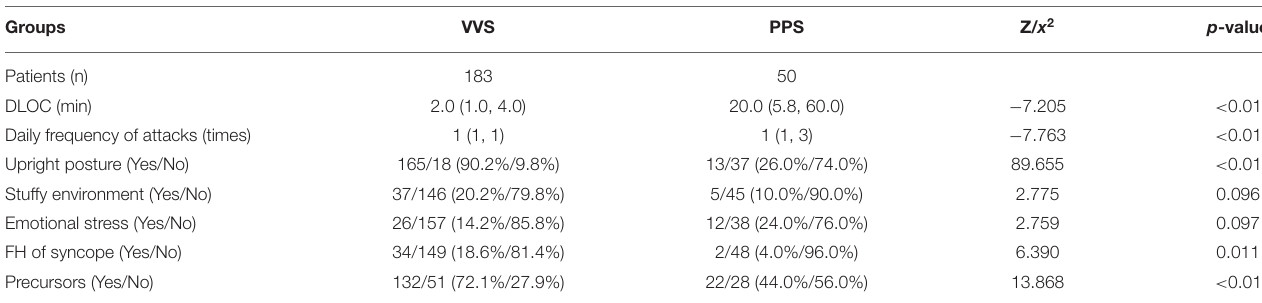
TABLE 2 | Clinical features of patients diagnosed with VVS and PPS groups in training set.